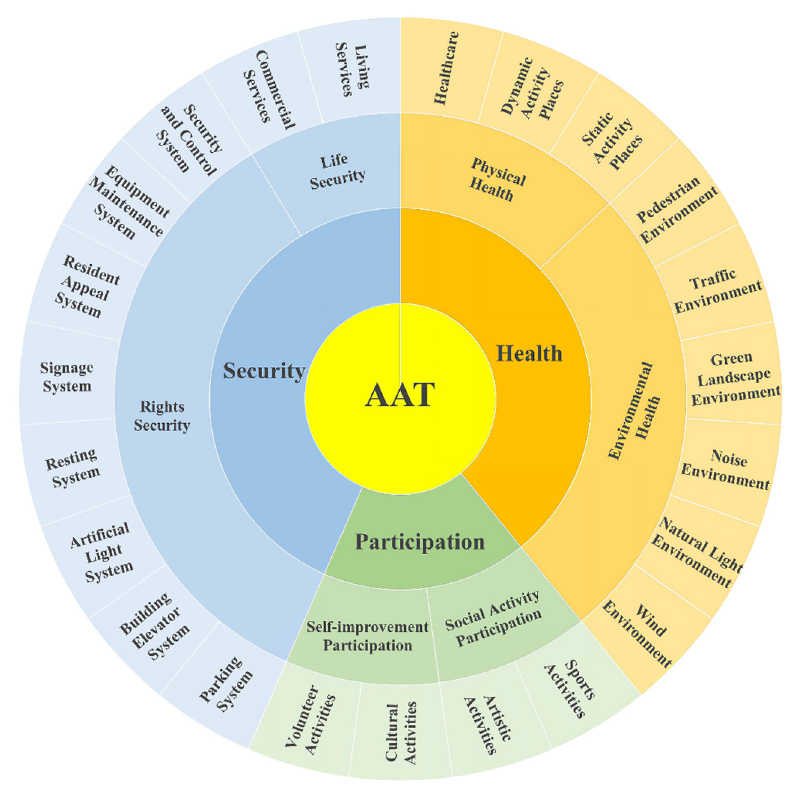
Figure 6. Final classification of the indicators.